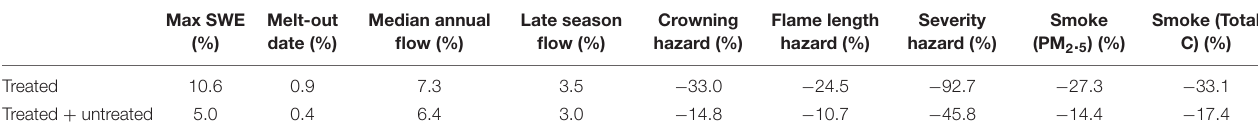
FIGURE 5 | Correlation matrix depicting treatment benefits across resource benefits. Positive relationships indicate a given treatment has a joint positive influence on both resources, while negative numbers indicate a given treatment enhances one benefit at the expense of another. Circle size increases with the absolute value of the correlation coefficient. Analysis was restricted to include only patches where a given treatment was implemented. Main topics are biomass production from harvest (Biomass), economics from harvest (Economics), fire hazard and wildfire smoke reduction (Fire/smoke), and water yield and snowpack retention (Hydrology). TABLE 2 | Average percent change in selected patch-level metrics for patches treated in the RA1 restoration